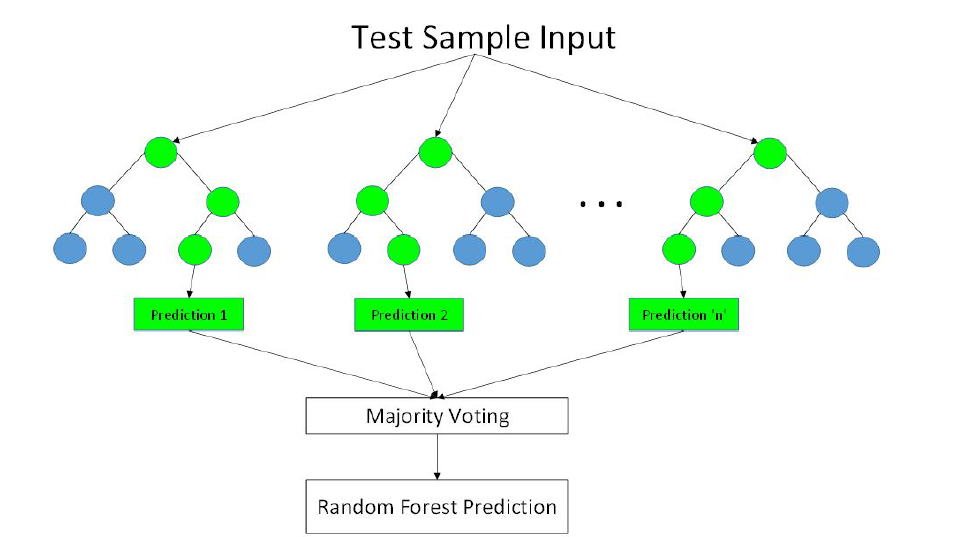
Figure 5. Random